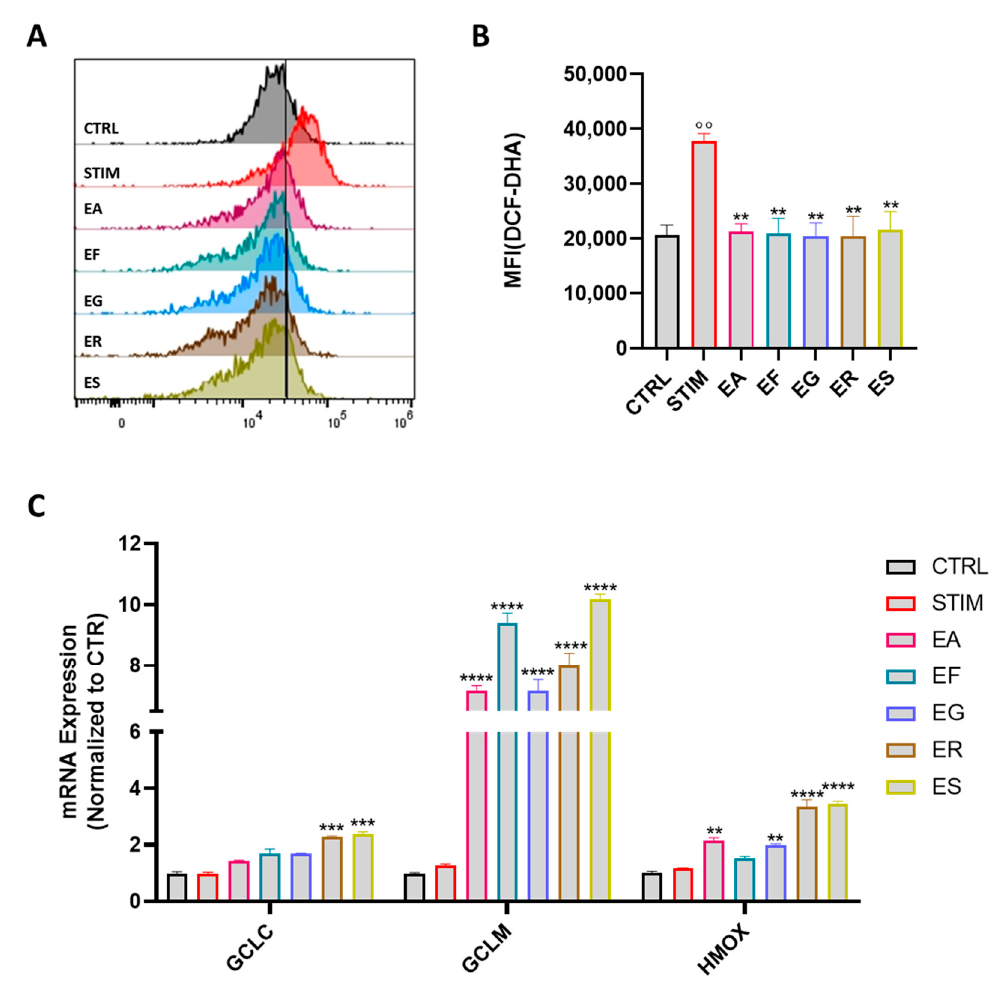
Figure 6. Effect of the Eucalyptus EOs on oxidative stress. J774A.1 macrophages pretreated with the EOs before being stimulated with LPS and INF γ . Representative histograms and relative quantification of DCF-DA fluorescence in J774A.1 cells ( A , B ). Relative mRNA levels of gclc, gclm and hmox-1 in J774A.1 macrophages determined by RT-PCR analysis after 6 h ( C ). Values are expressed as mean ± SEM from three independent experiments. ◦◦ p < 0.01 indicates significant effect of LPS/INF- γ - stimulated cells (STIM) compared to unstimulated cells (CTRL); ** p < 0.01, *** p < 0.001, **** p < 0.0001 indicate significant effect of Eucalyptus extracts compared to stimulated cells. EA = E. alba , EG = E. eugenioides , EF = E. fasciculosa , ER = E. robusta and ES = E. stoatei